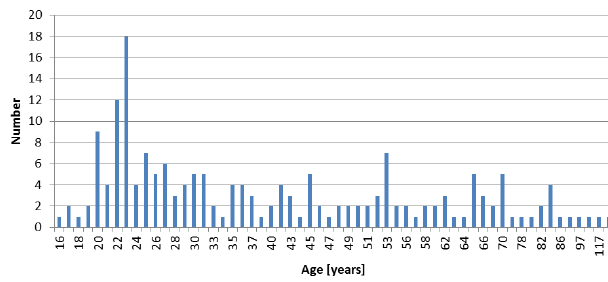
Figure 2. Number of LTFEs per age in 2019 ( n = 183; age of 22 LTFEs